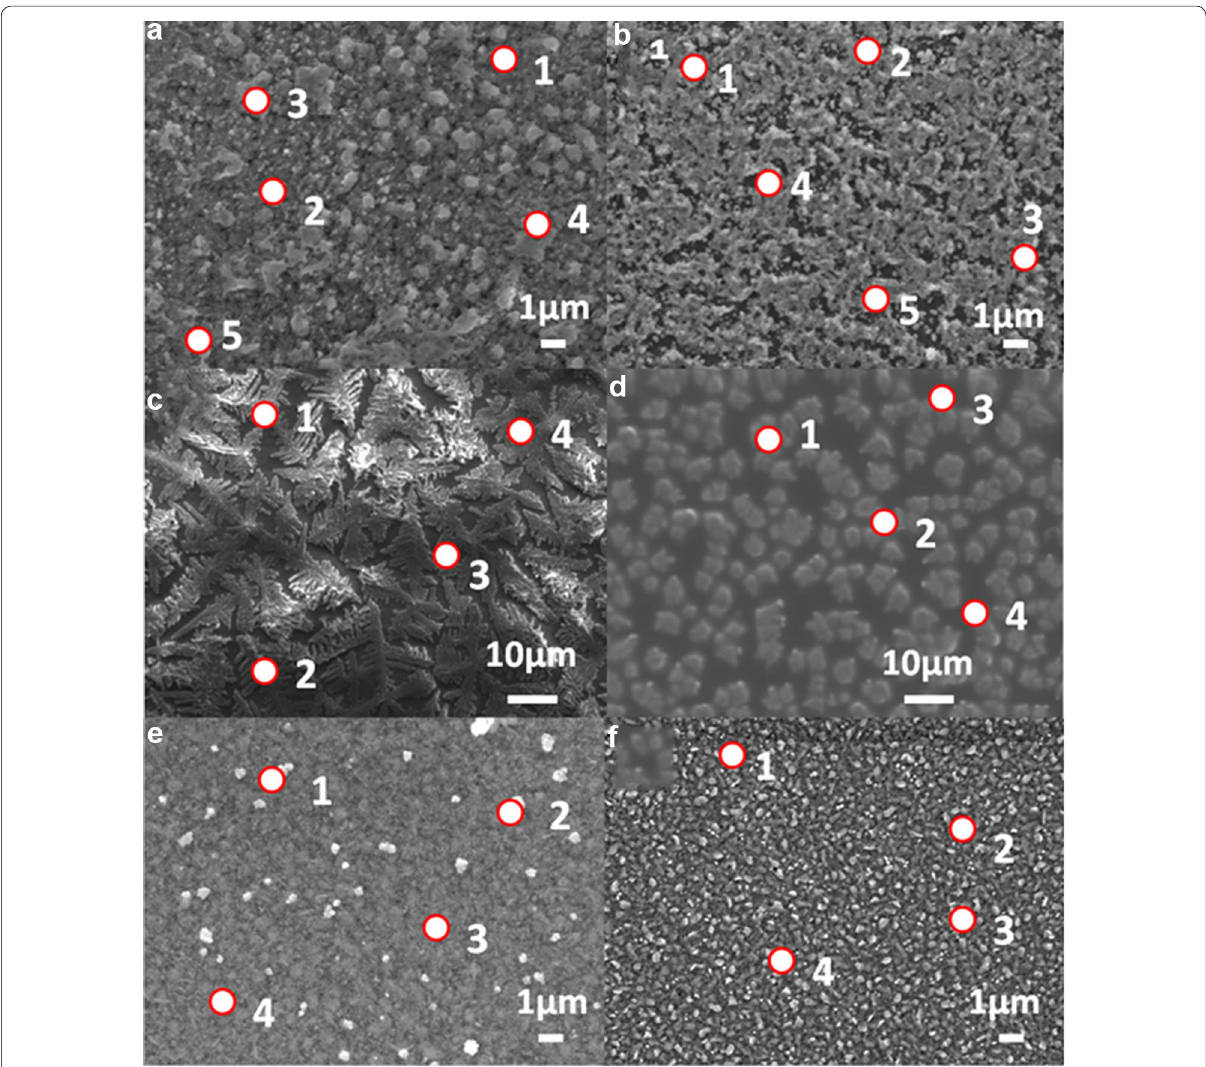
Fig. 7 SEM images observed for elemental analysis of A 3 BX 6 films [Ag 3 BiI 6 : ( a , b ); Ag 3 BiI 3 (SCN) 3 : ( c , d ); Cu 3 BiI 6 : ( e , f )] grown on different substrates [TiO 2 : ( a , c , e ); NiO: ( b , d , f )]. The marked spots indicate the positions of elemental analysis, which is related to the results shown in Tables 8, 9, 10, 11, 12 and 13